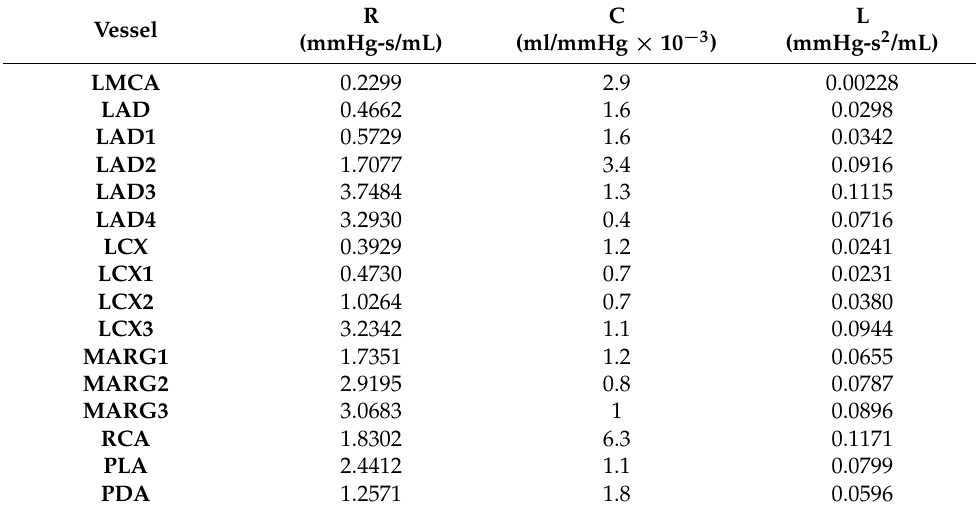
Table 1. Model parameter values. See Figure 1 for vessel connectivity. The rows are colour-coded to suggest the major epicardial coronaries, either LAD, LCX, or RCA.